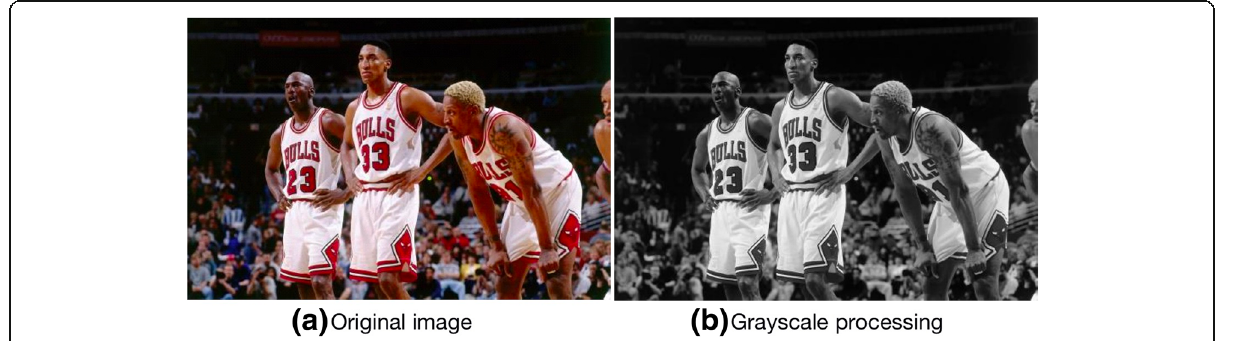
Fig. 1 Grayscale of original video frame. a Original image. b Grayscale processing